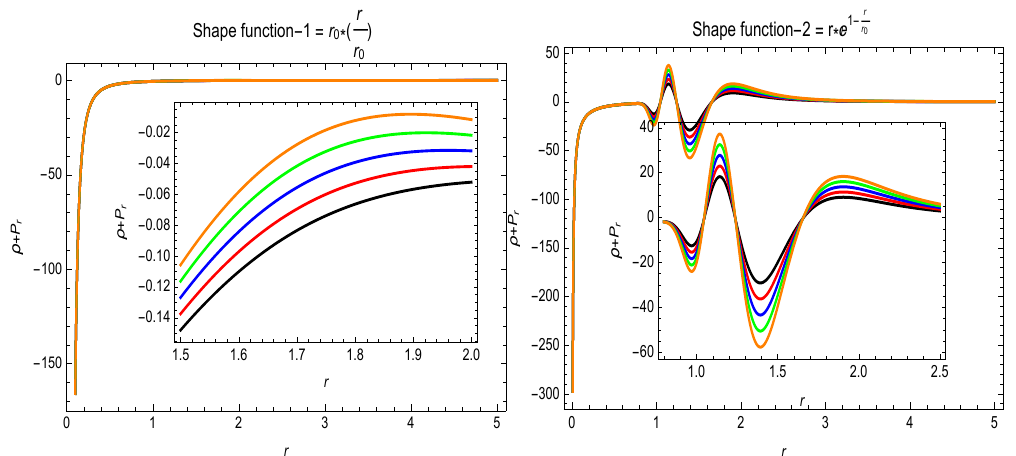
Figure 6. The variational behavior of ρ + P r . Here, α = 0.10 ( (cid:70) ), α = 0.20 ( (cid:70) ), α = 0.30 ( (cid:70) ), α = 0.40 ( (cid:70) ), α = 0.50 ( (cid:70) ), β = 0.25, and γ =